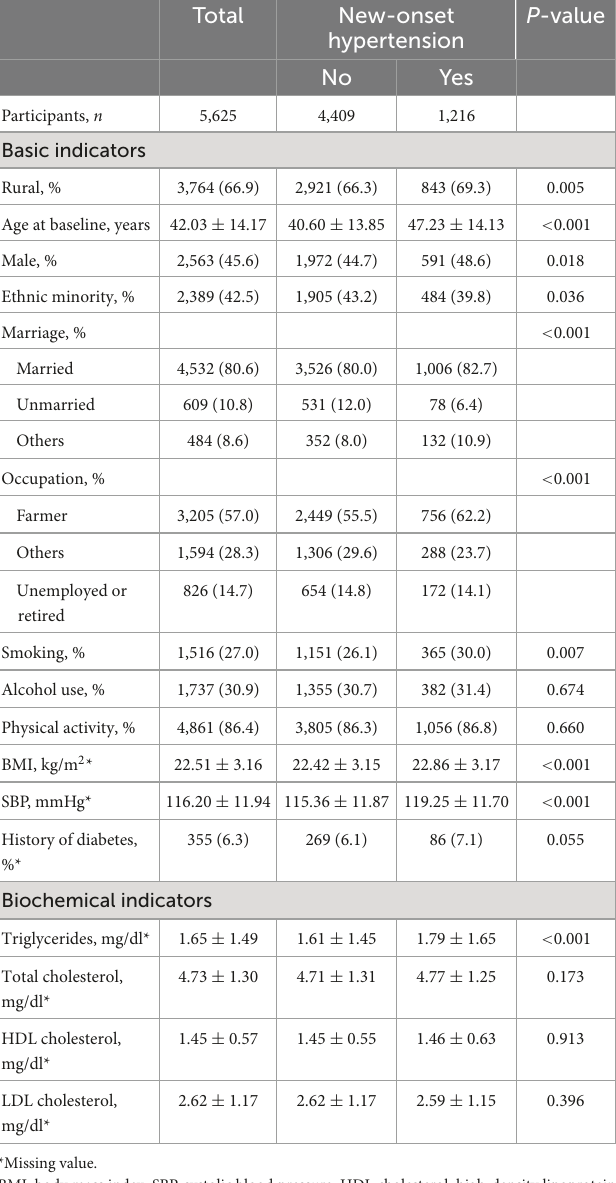
TABLE 1 Baseline characteristics according new-onset hypertension. TABLE 2 Hazard ratios (95% confidence intervals) of hypertension